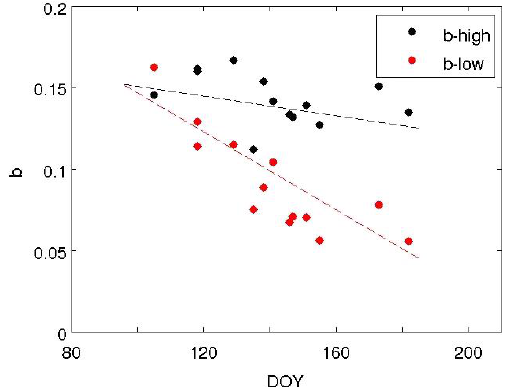
Fig. 11. Temporal variation of the b parameter (in units of m 2 kg − 1 ) for high and low vegetation. Time is in day of year (DOY) 2010. For b high the correlation is insignificant with r = − 0.37; for b low the correlation is significant (p-value=0.0003 and r = − 0.85); the trend in b low is significant at the 0.1% level and equal to − 0.0012m 2 kg − 1 day − 1